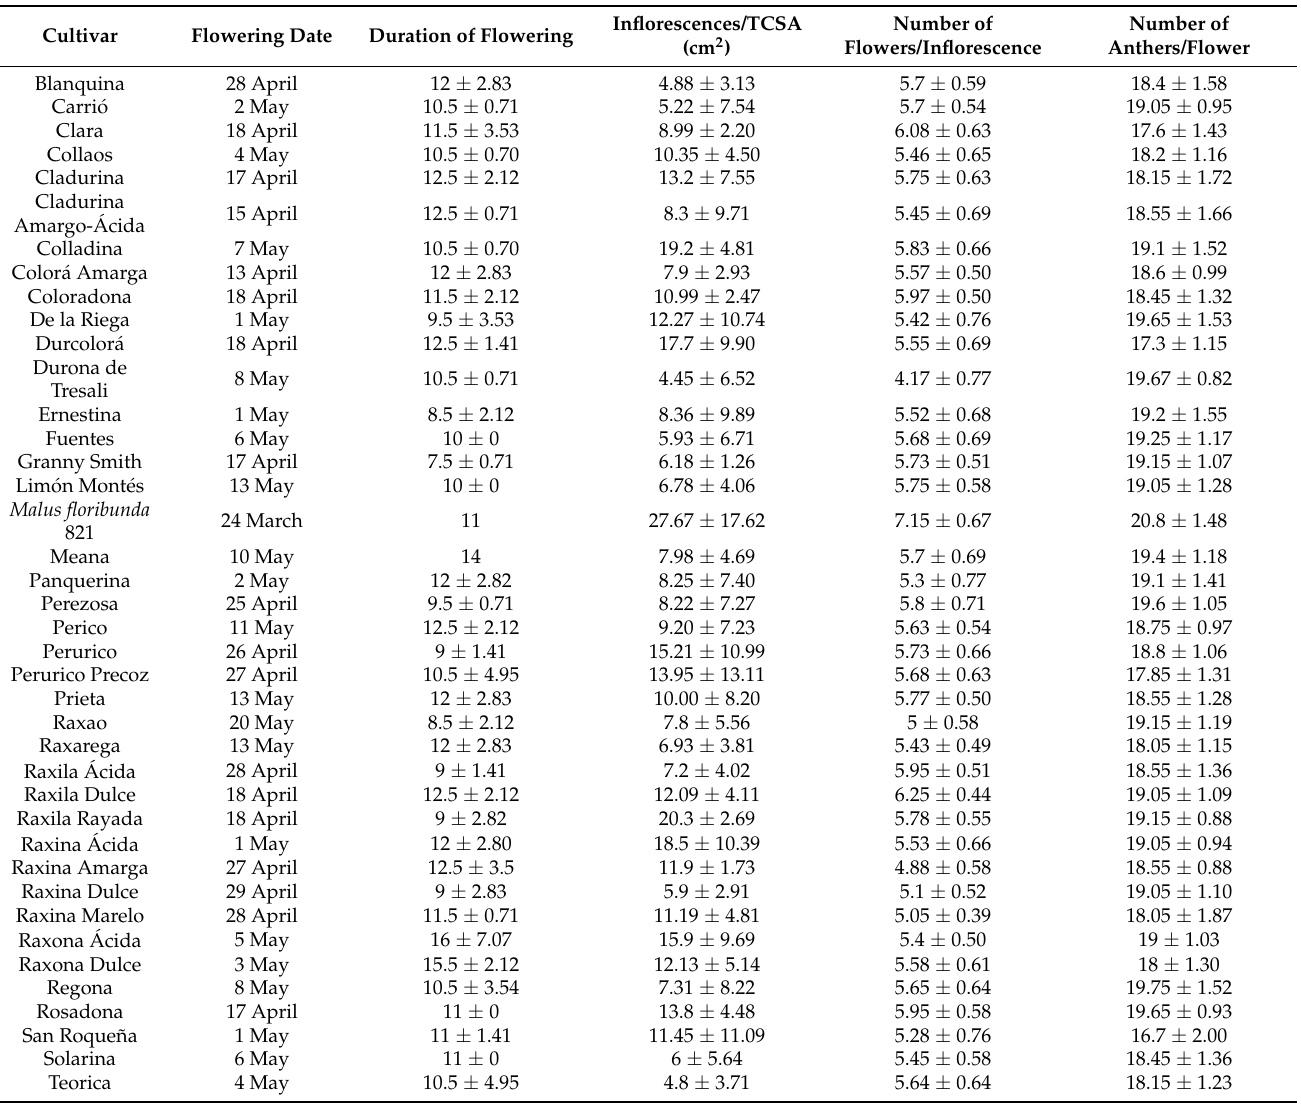
Table 1. Flowering time, flowering duration, flowering intensity (number of inflorescences/cm 2 of trunk cross-sectional area) and floral characterization of 44 domesticated apple cultivars and Malus floribunda 821 in Villaviciosa (north-western Spain) in two successive years (i.e., 2018–2019 or 2019–2020). Data from two successive flowering seasons was pooled to obtain a unique value for each cultivar and variable. Two-year mean values are accompanied by the standard deviation. ANOVA results using the year and cultivar as factors are